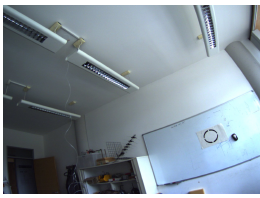
Figure 7: Sample image of our vignetting measurement series. The measurement target is the area inside the black circle on the A3 sheet mounted on the white- board.